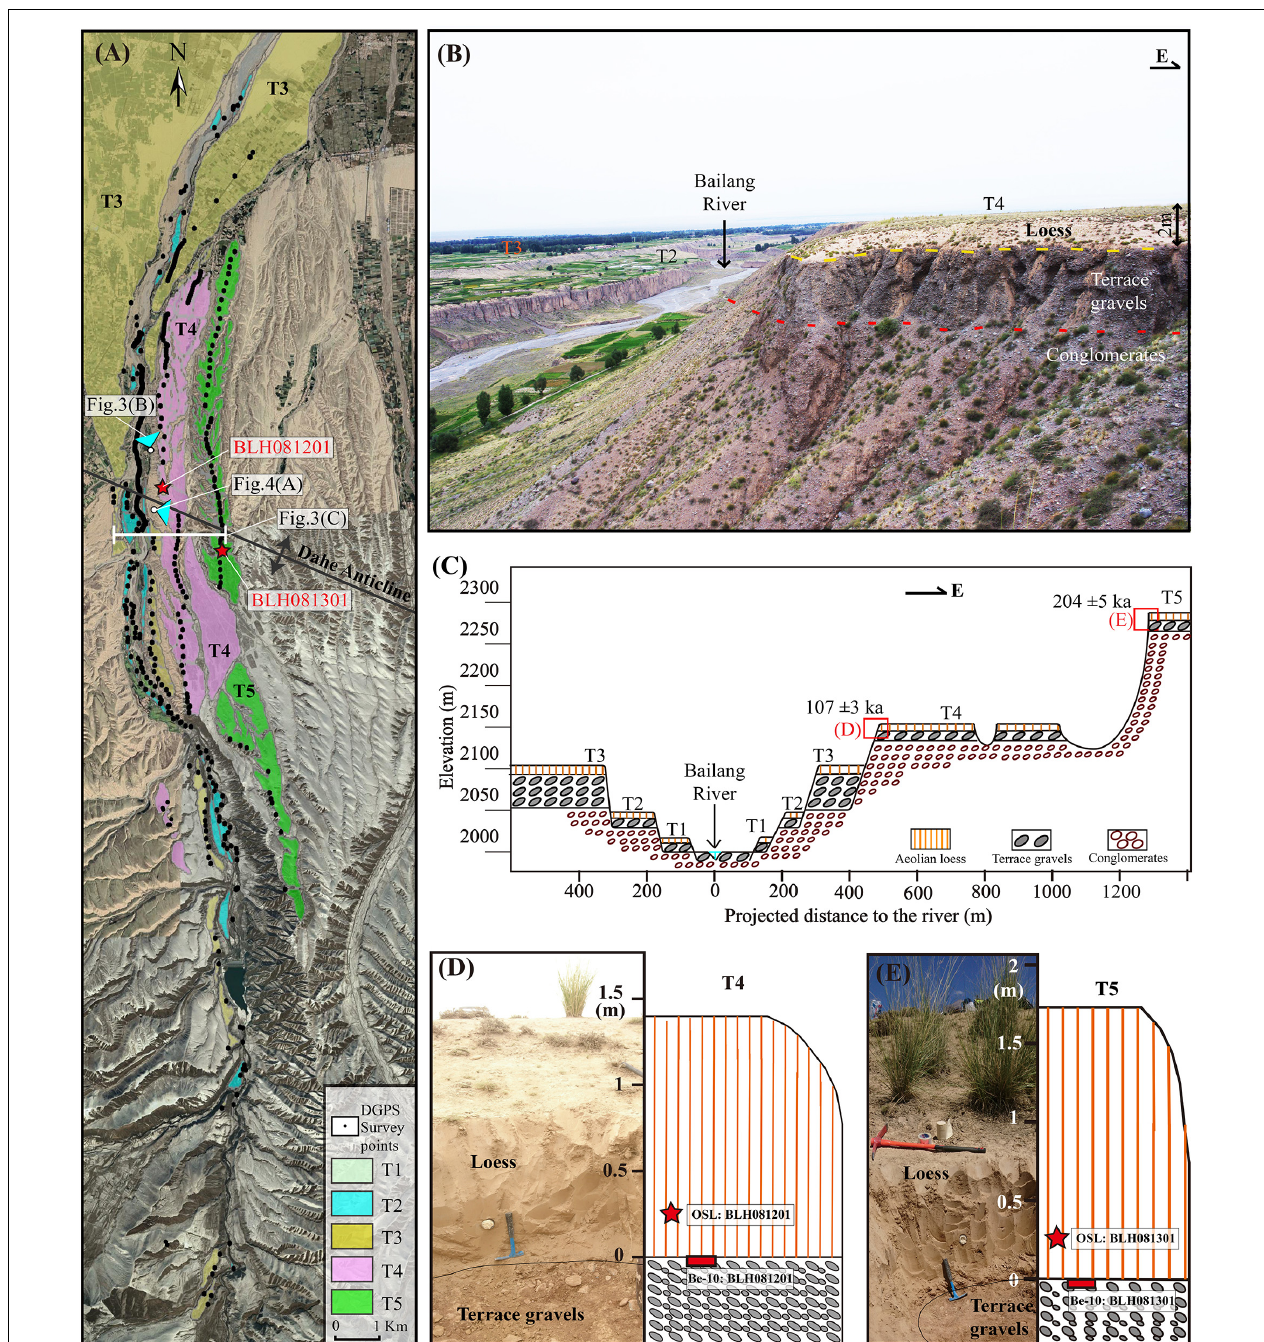
FIGURE 3 | (A) Distributions of terraces along the Bailang River. (B) The photo showing the terrace staircases and the composition of terrace T4. (C) The sketched transect near the anticline (location shown in the Figure 3A ) showing the stratigraphy and positions of the optically stimulated luminescence (OSL) and 10 Be samples. (D) The photo showing the T4 surface of the gravel top at which the 10 Be sample was taken and above which the OSL sample was taken close to the base of aeolian loess. (E) The photo showing the T5 surface of the gravel top, at where the 10 Be sample was taken and above which the OSL sample was taken close to the base of aeolian